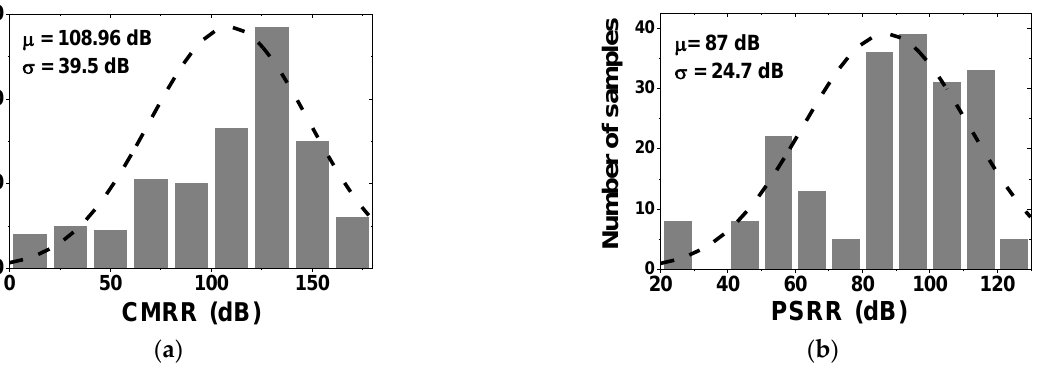
Figure 13. Monte Carlo simulation results of the proposed CCIA: ( a ) Common mode rejection ratio CMRR; ( b ) power supply rejection ratio PSRR.